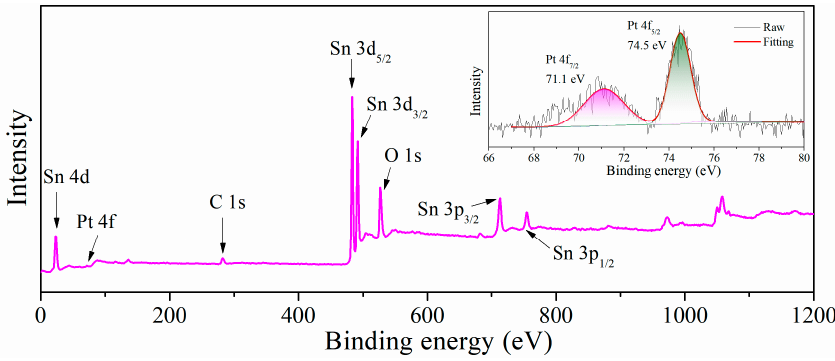
Figure 3. XPS spectra of Pt-SnO 2 .